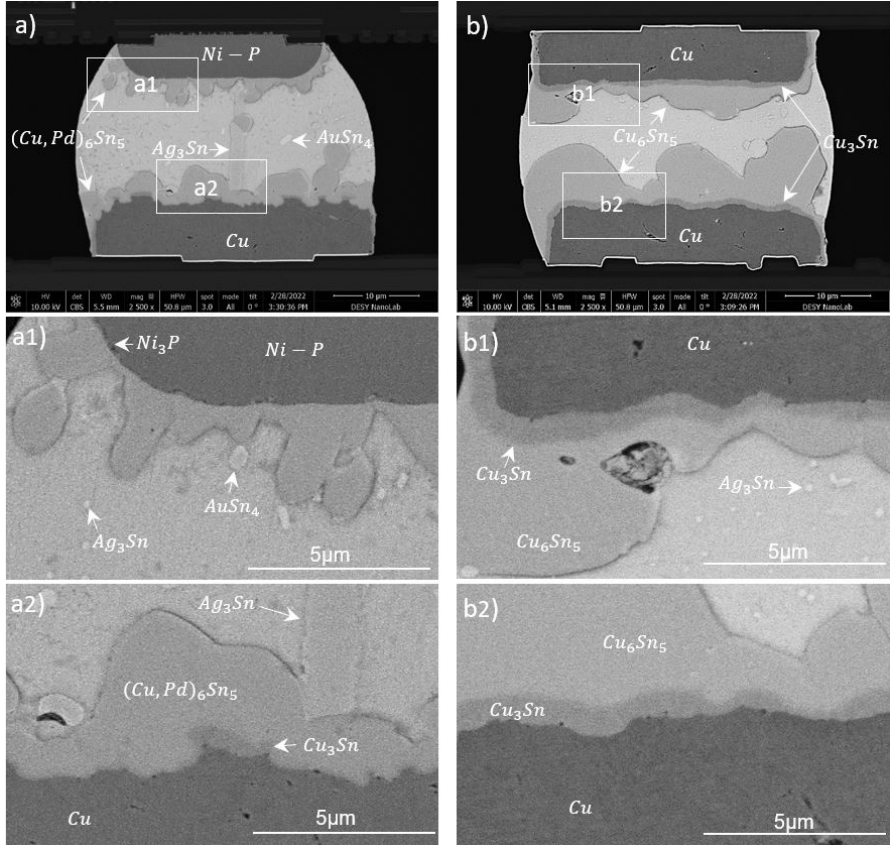
Figure 13. Cross-sectional view of Cu30/100-SAC-ENEPIG28 ( a ) and Cu30/100-SAC-Cu30/100 ( b ) solder joints after TC tests. Magnified views of upper and lower UBM interfaces for both samples are shown as ( a1 ) and ( b1 ); and ( a2 ) and ( b2 ),